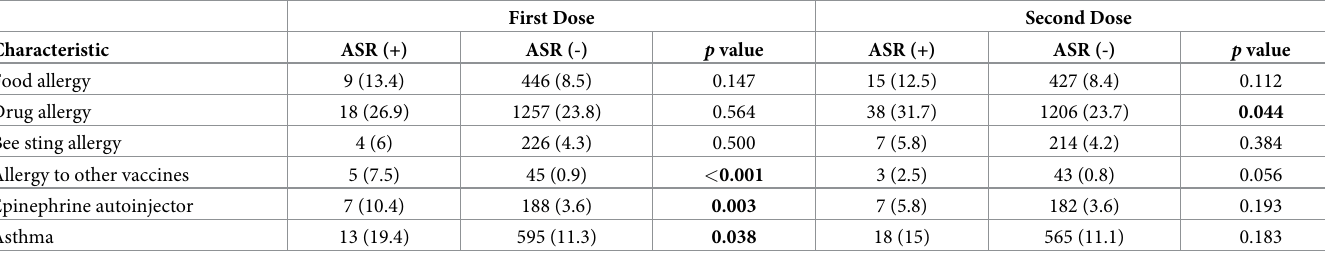
Table 3. Allergic systemic reaction (ASR) and allergic